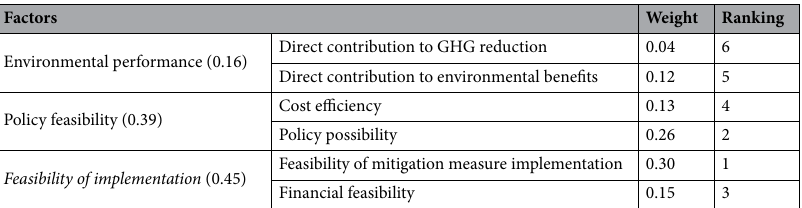
Table 4. Overall AHP-weighting of the feasibility of climate policy implementation (CR =